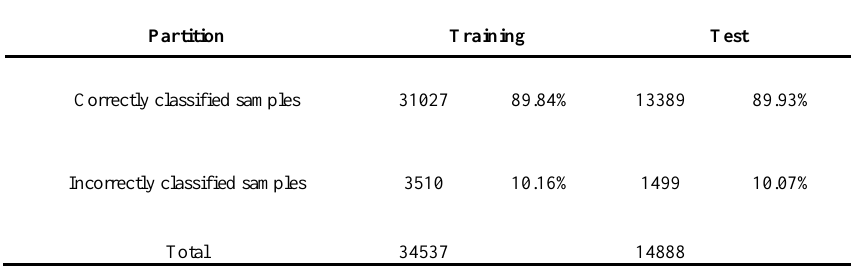
Table 7. Accuracy of decision tree of ATM transactions with respect to month and